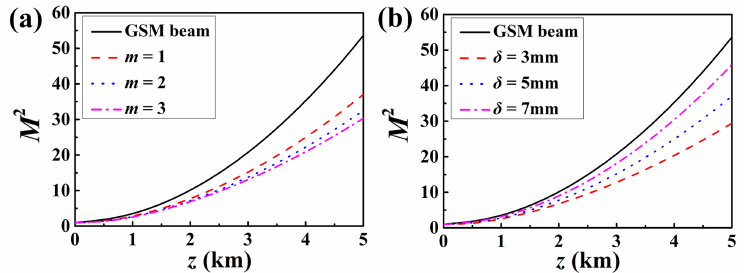
Figure 7. Normalized propagation factor for SSS beams traversing through oceanic turbulence for various ( a ) beam orders and ( b ) coherence lengths. The dark line on the graphs denotes the corresponding result for a GSM beam.